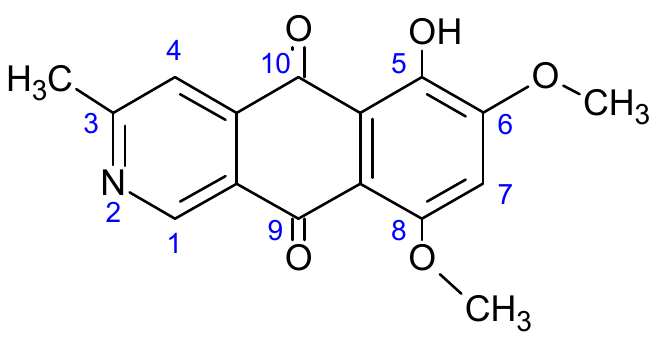
Figure 1. Structure of 8- O -methylbostrycoidin.